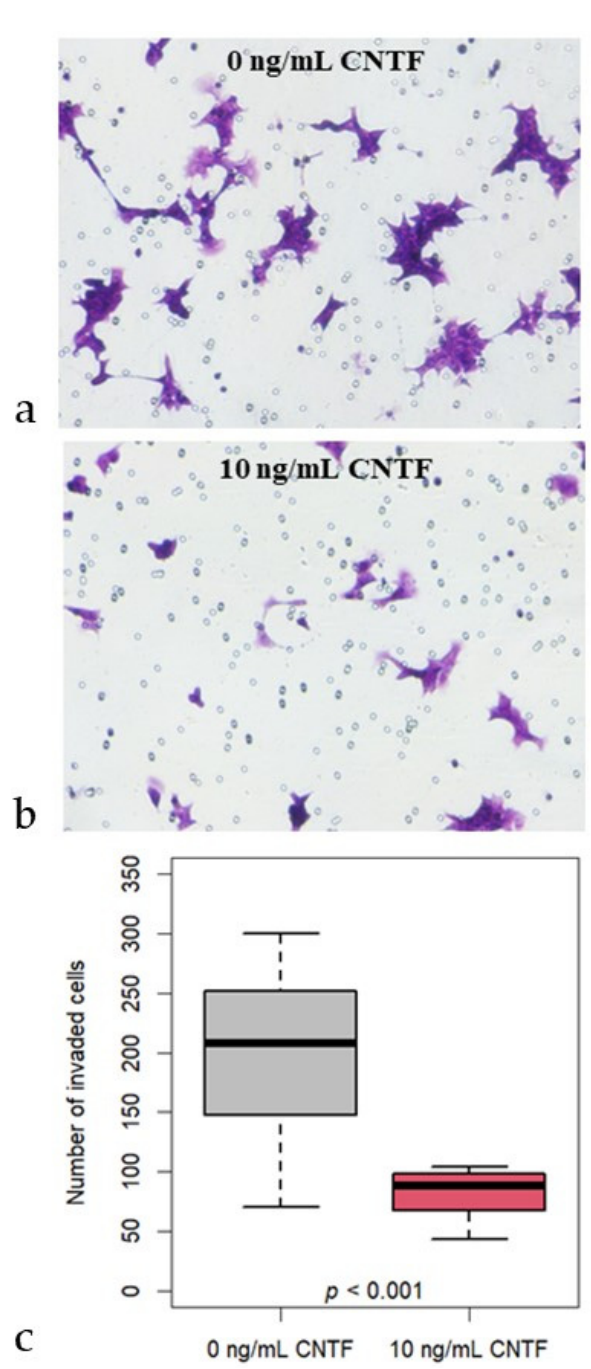
Figure 7. Transwell invasion assays. Representative images of 22Rv1 cells stained with crystal violet showing CNTF treatments effect: ( a ) untreated 22Rv1 cells; ( b ) 22Rv1 cells treated with 10 ng/mL rhCNTF; ( c ) Boxplot shows that the distribution of the number of 22Rv1 invaded cells is significantly ( p < 0.001) lower in the group treated with 10 ng/mL CNTF (median 89; IQR 71-98) compared to the untreated controls (median 208; IQR 149-247).